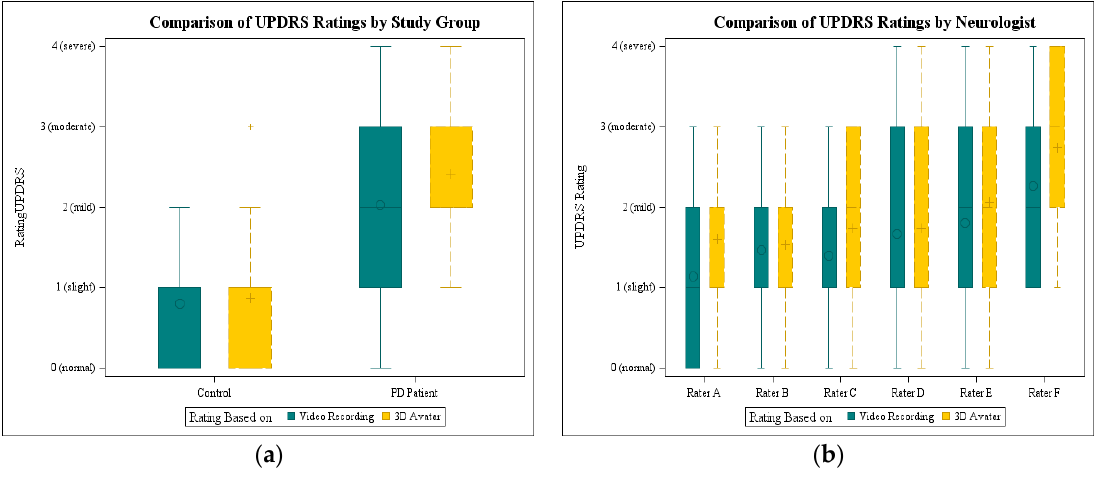
Figure 6. Boxplots visualizing the comparison of UPDRS ratings ( a ) by study group and ( b ) by rater.